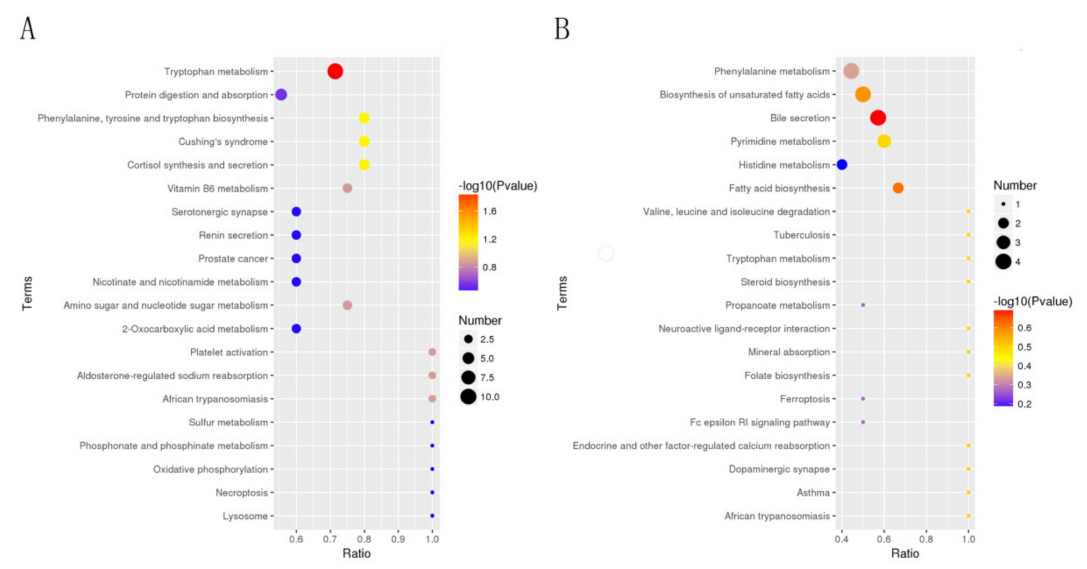
Figure 10. The most enriched KEGG pathway of the DMs. Positive DMs ( A ), negative DMs ( B ).